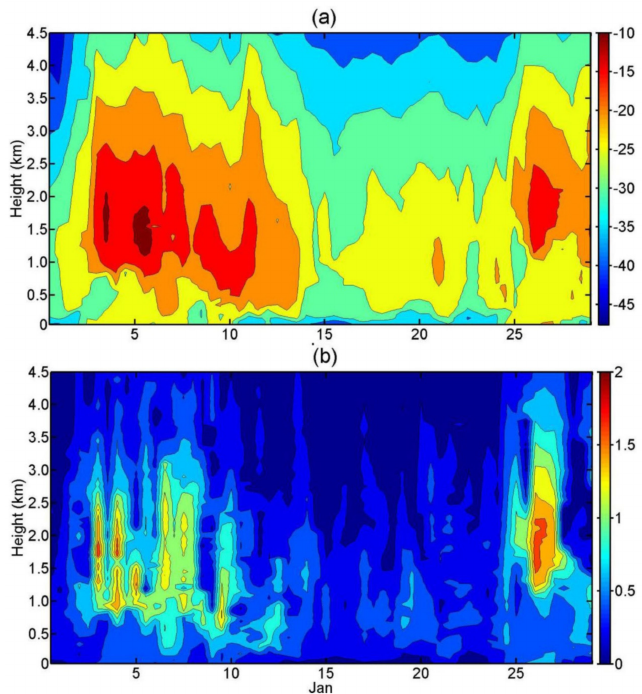
Figure 2. Cross-sections of temperature ( ◦ C) ( a ) and specific humidity (g / kg) ( b ) obtained from SHEBA radiosonde profiles during January 1998. The track during this period is shown in Figure 1 (red